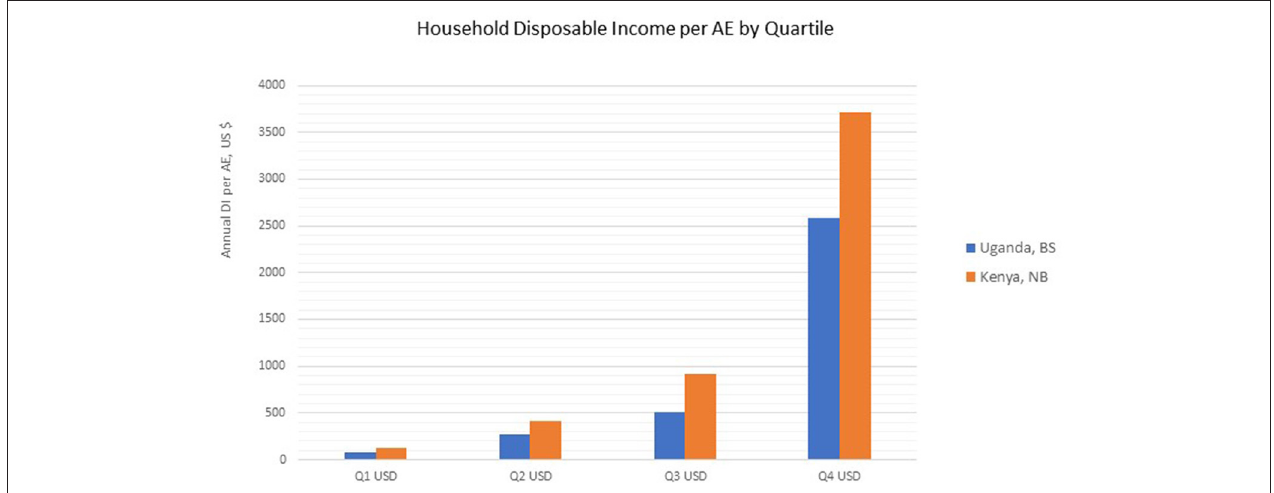
FIGURE 5 | Disposable incomes per Adult Equivalent (AE) by Quartile (Q) at the two study sites, BS and NB (Jan 2016 USD exchange rate).